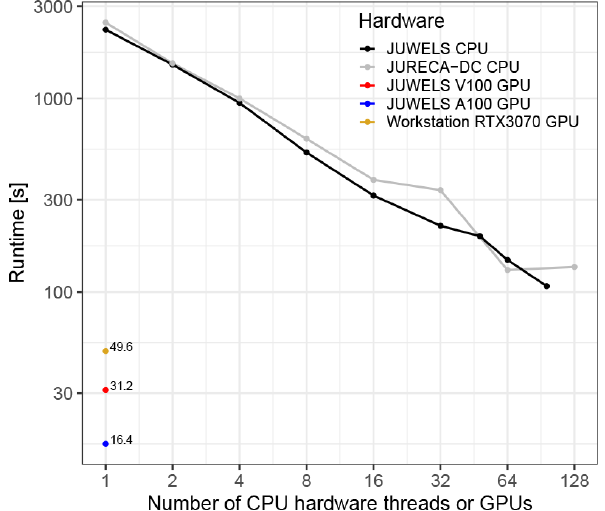
Figure 16. Scaling for the Malpasset case ( δx = 10m) on a single node and on single GPUs. GPU speed ups relative to a full JUWELS node are 6.5 (A100), 3.4 (V100), and 2.2 (RTX 3070).